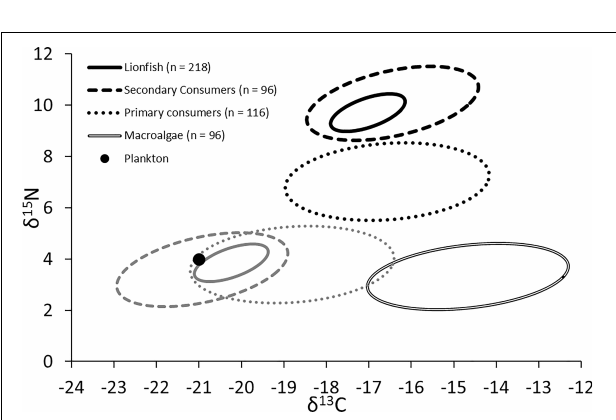
FIGURE 7 | Black shapes: isotopic niche of lionfish, secondary consumers (competitors), primary consumers (prey), and primary producers (both plankton and macroalgae). Gray shapes: predicted resource pools of lionfish, secondary consumers, and primary consumers.